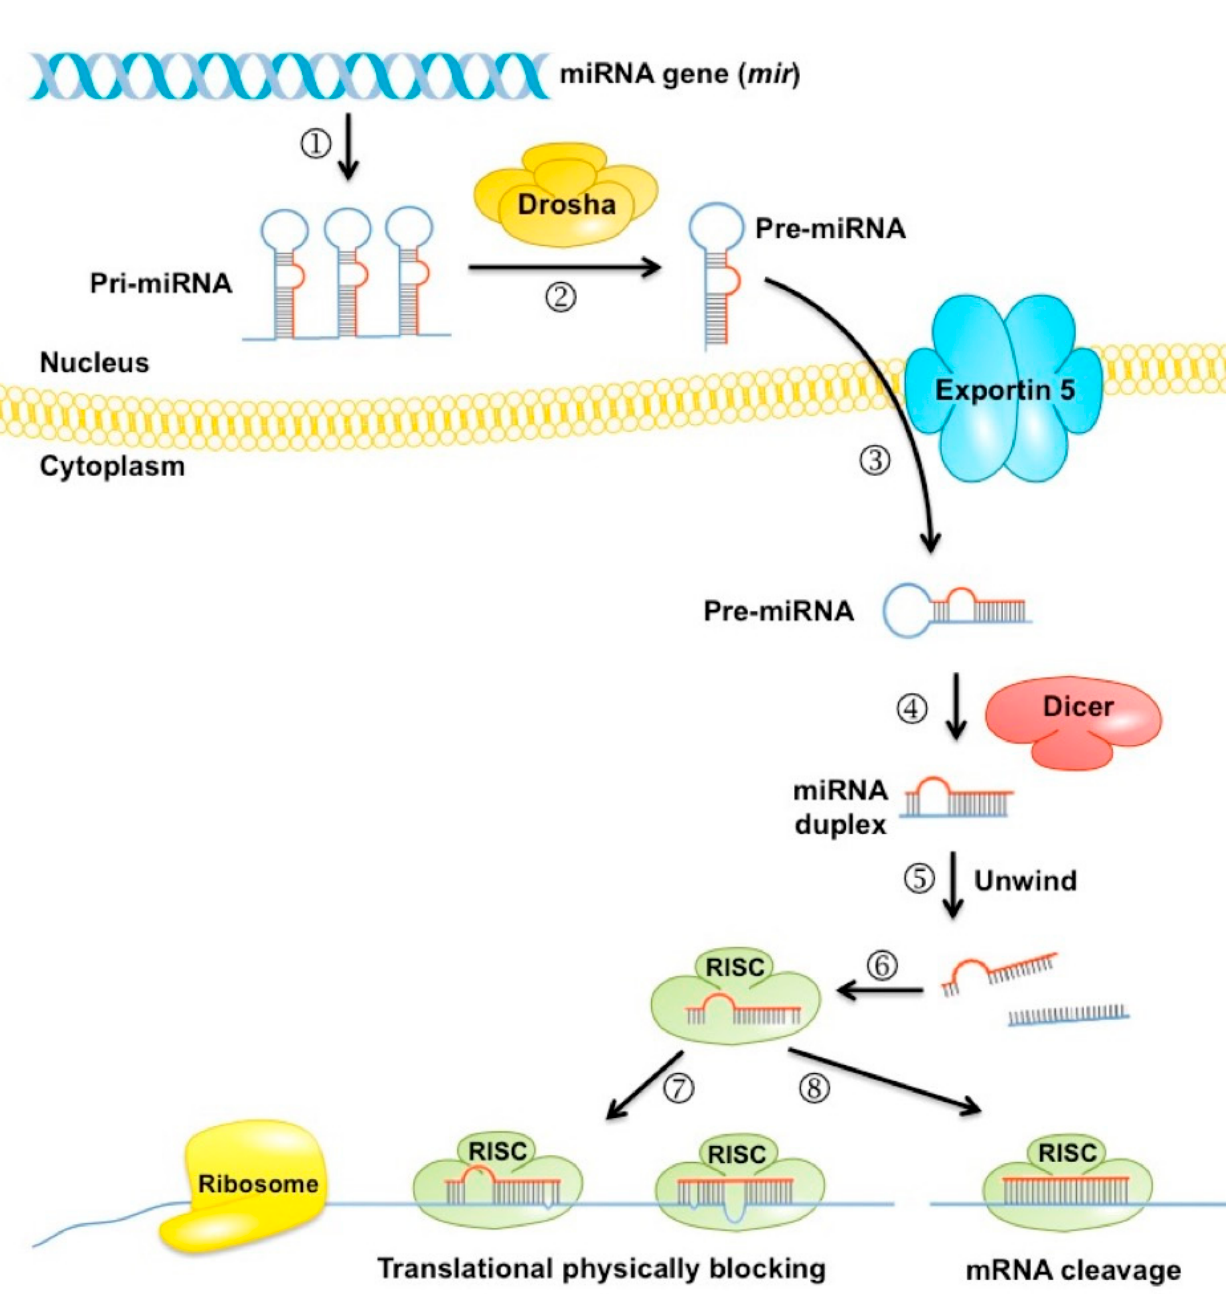
Figure 3. The current model for the biogenesis and post-transcriptional suppression of microRNAs: 1 (cid:13) In the nucleus, the miRNA gene is a transcript from RNA polymerase II, which produces a primary miRNA: pri-microRNA (pri-miRNA). 2 (cid:13) The pri-microRNA transcripts are first processed into ~70-nucleotide pre-miRNAs by Drosha inside the nucleus. 3 (cid:13) Pre-miRNA is quickly exported by Exportin-5 to the cytosol. 4 (cid:13) In the cytoplasm, the pre-miRNA is processed by Dicer, thus producing a double-ribbon miRNA. 5 (cid:13) This product is unwound and then joined with Argonaute to form the complex RISC. 6 (cid:13) The RISC complex obtains the pairing between the miRNA and the homolog target mRNA via reverse base complement. 7 (cid:13) It subsequently acts on its target through translational repression or mRNA cleavage 8 (cid:13) , depending, at least in part, on the level of complementarity between the small RNA and its